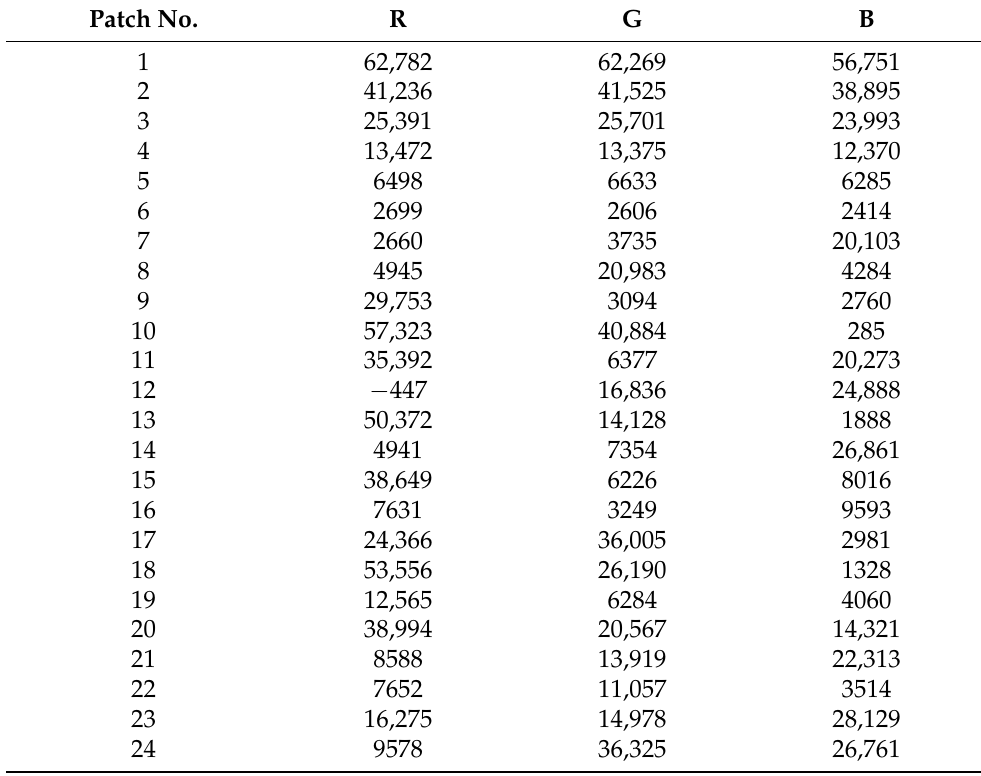
Table 4. The sRGB values (16-bit) of the X-Rite ColorChecker Classic board, calculated from the spectra measured with the spectroradiometer, and scaled to match the X-Rite nominal values. Patch No.